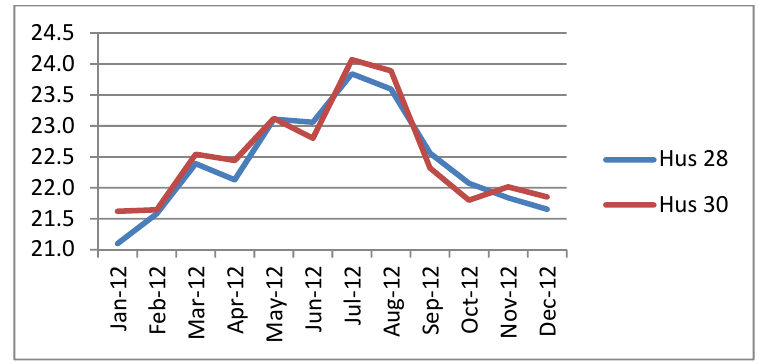
Figure 5. Monthly average living area temperature of the buildings in Portvakten